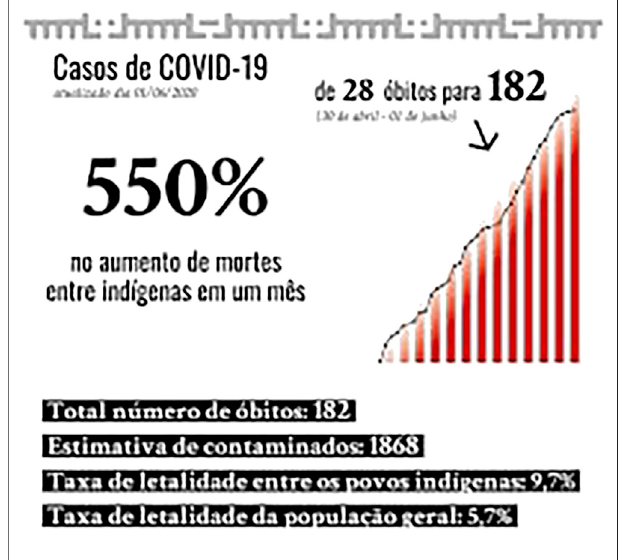
FIGURE 5 | https://www.facebook.com/apibo fi cial/photos/pcb.